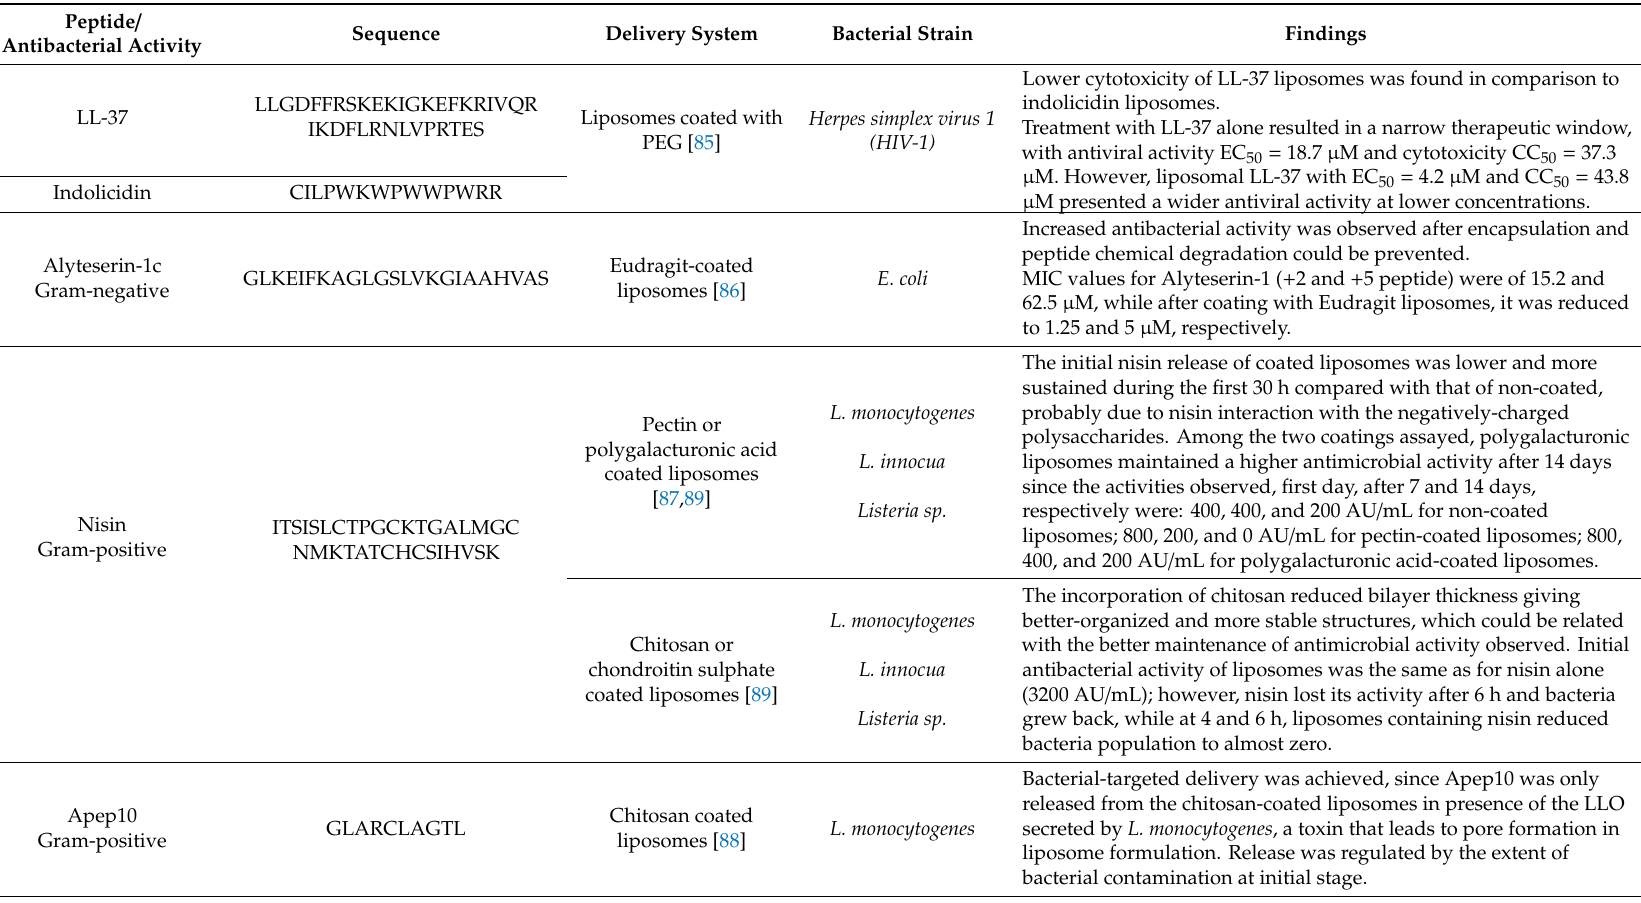
Table 4. Overview of the di ff erent liposomes and liquid crystalline nanoparticles (LCNPs) as delivery systems for